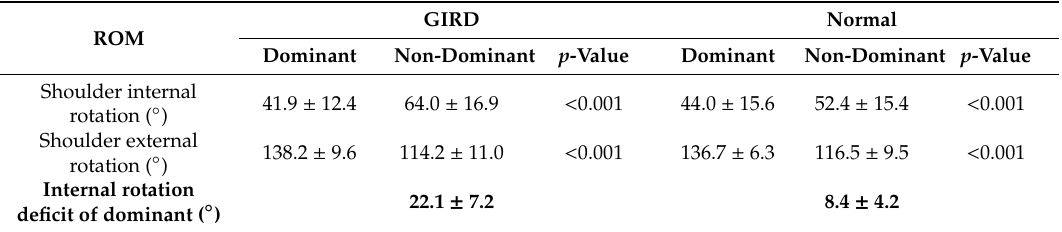
Table 1. Passive range of motion of dominant and non-dominant shoulders.